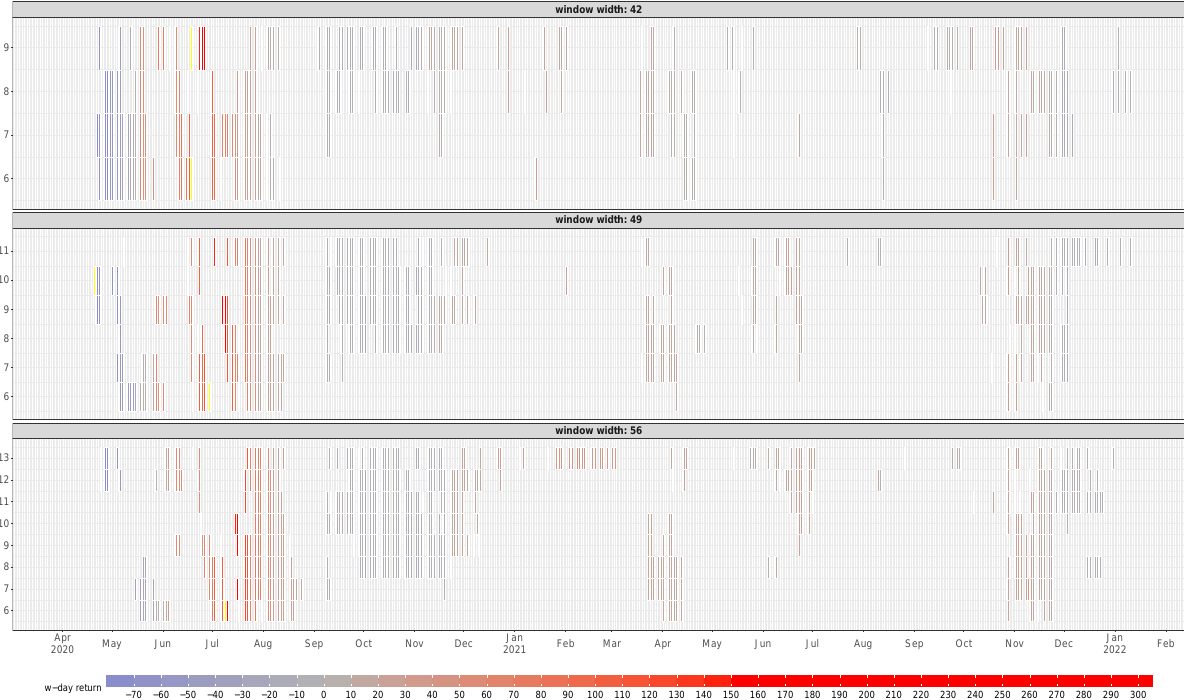
Figure 5. Heatmap of the w -day returns, y time lag p = { 6,7, . . . ,13 }